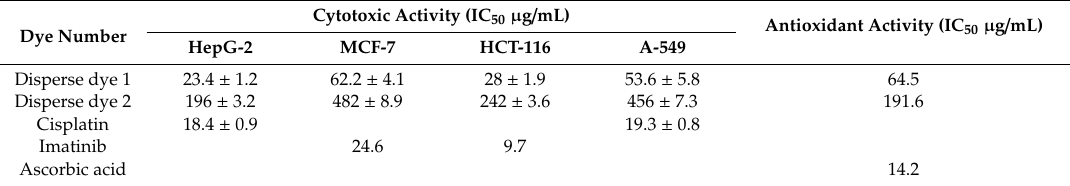
Table 4. Antitumor and antioxidant activities of disperse dyes 1 and